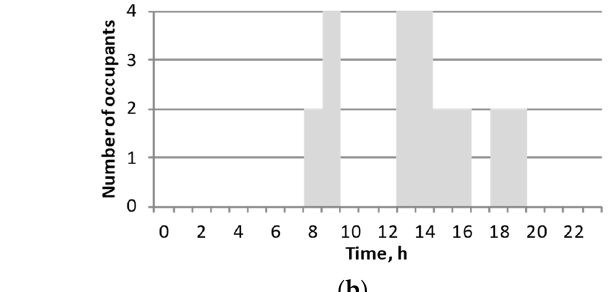
Figure 4. Schedule of occupancy in the living room during working days ( a ) and weekend ( b ). According to the EN 15193-1:2017 [37] standard, the illuminance depends on the size of a room. An average value of light intensity was adopted in the model, taking into ac- count the intended use of the room and the type of work carried out there. For the study and bathrooms, a maximum power factor of 4 W ∙ m − 2 was adopted. With reference to cor- ridor, utility and vestibule room, children’s rooms, living room, the assumed value was 2 W ∙ m − 2 ;whereas as for the garage, 1 W ∙ m − 2 was assumed. The light source was a light-emit- power depended on the intensity of natural light). Heat gains from the equipment and its schedule were assumed in accordance with the ASHRAE standard [38]. The operation schedule for the living-room is shown in Figure 5. To limit solar gains, window blinds were used when the lighting intensity in the room was above 200 lx and the indoor temperature exceeded 22 ◦ C.